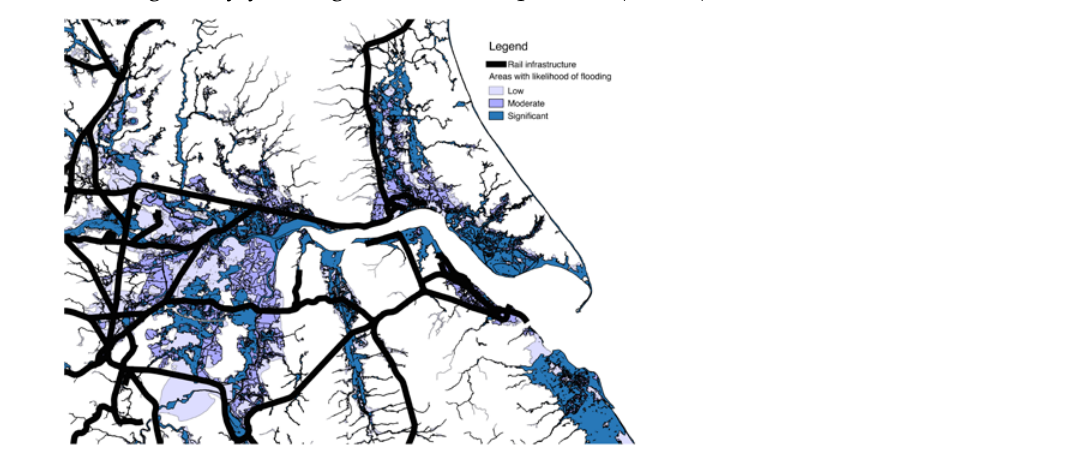
Figure 9. Illustration of part of the NaFRA flood likelihood map for England and Wales and its intersection with the railway infrastructure